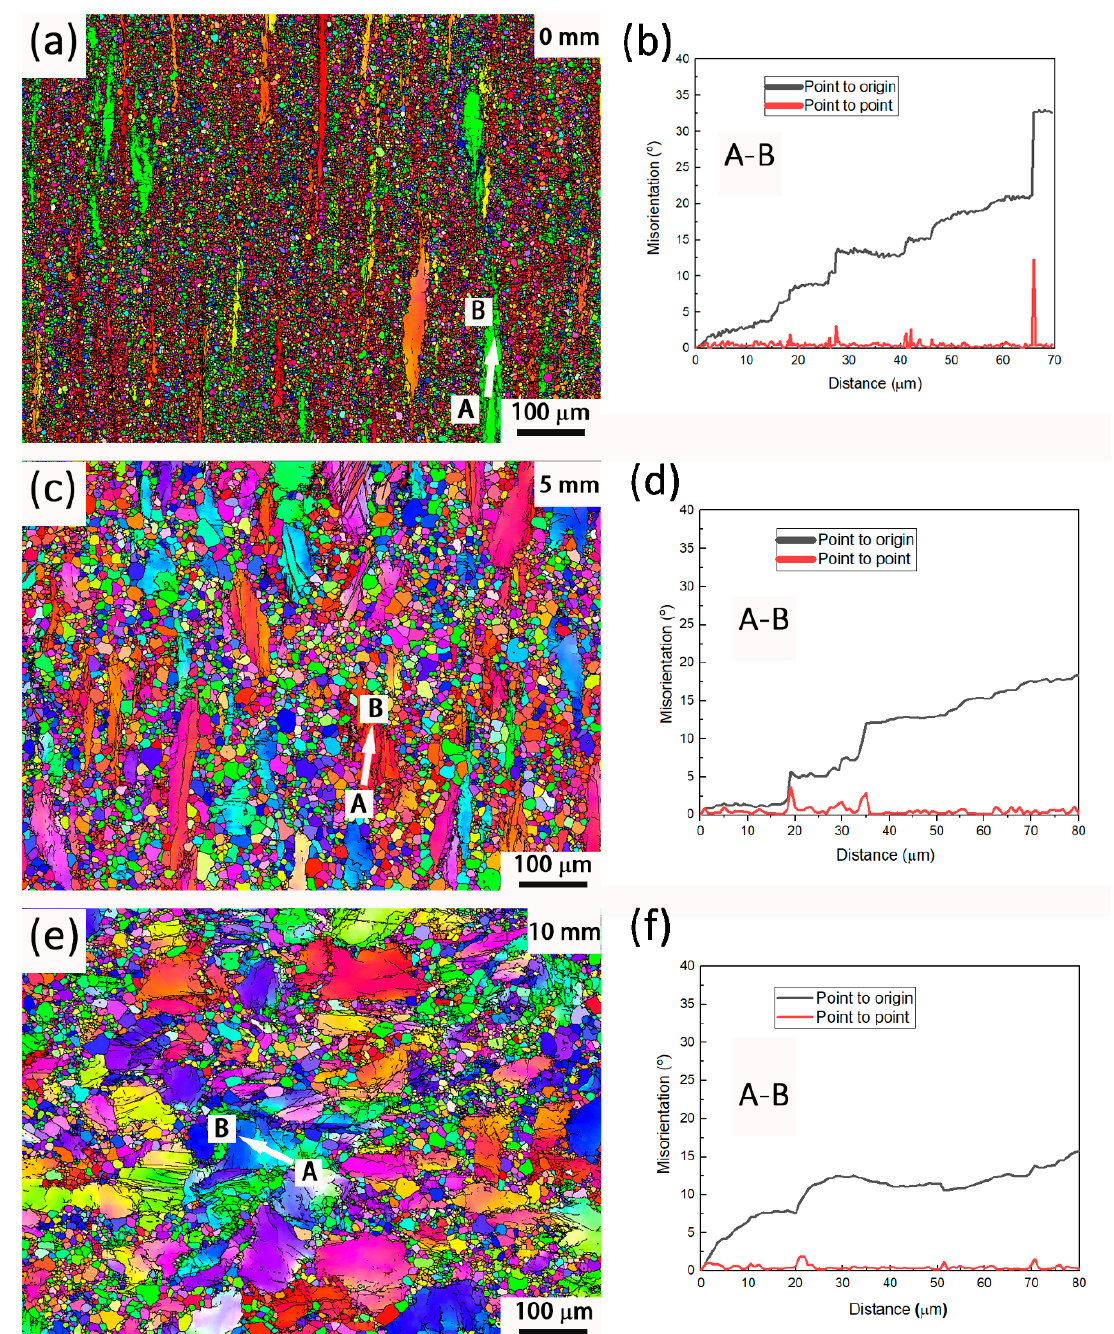
Figure 13. EBSD results of the interrupted die sample extruded at 400 °C at different positions ( a , b ) 0 mm, ( c , d ) 5 mm, and ( e , f ) 10 mm below the die exit: ( a , c , e ) are IPF maps, and ( b , d , f ) are the line profiles of the misorientation angle along the arrow AB shown in ( a , c , e ).